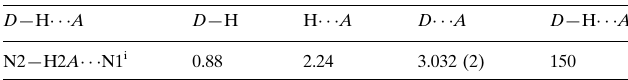
Hydrogen-bond geometry (A˚ , (cid:1)